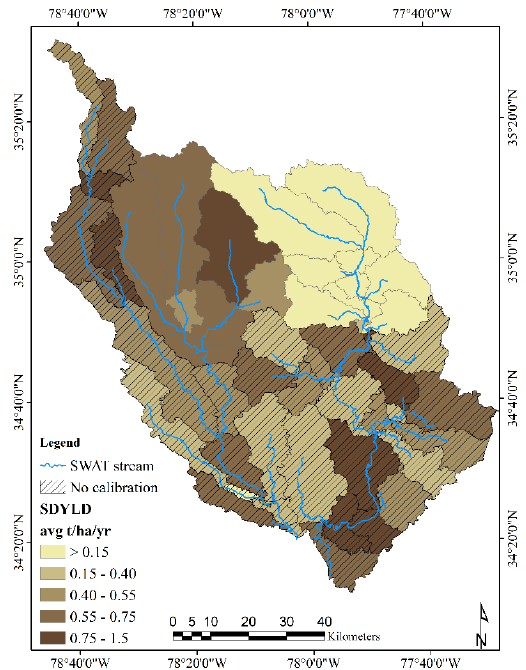
Figure 4. Yearly average estimates of Sediment Yield (SYLD) from the validation period of 2010–2011 using SWAT-CUP. using